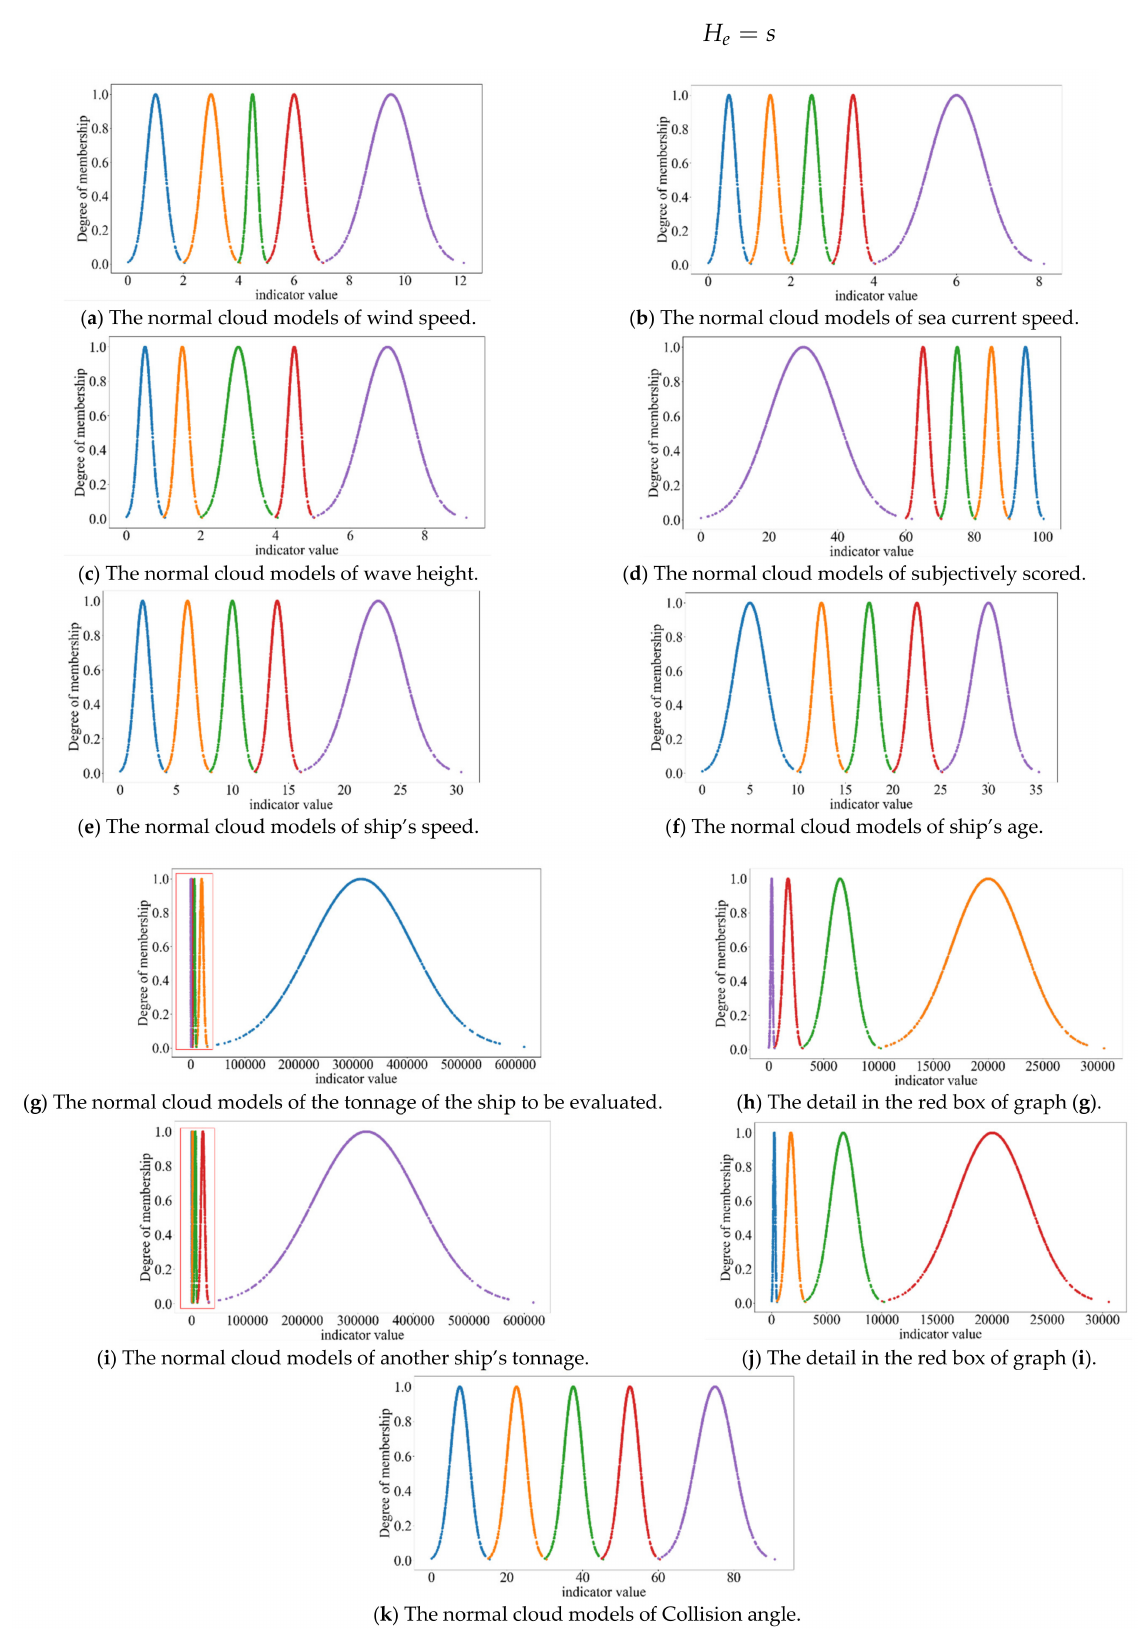
Figure 4. The cloud maps of the evaluation level of the emergency